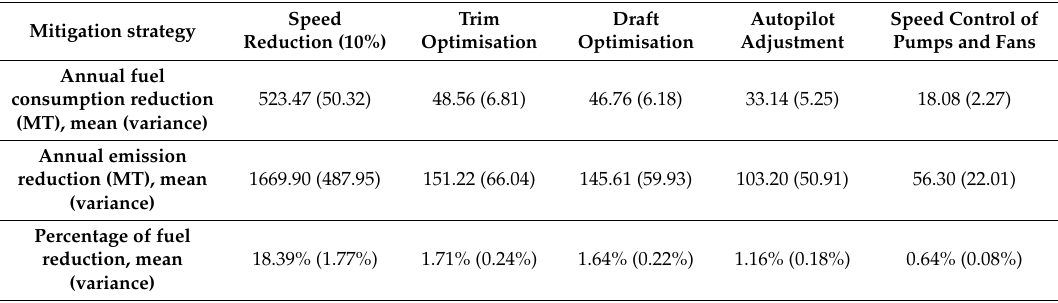
Table 4. Annual fuel consumption reduction, emission reduction and percentage fuel reduction for di ff erent mitigation strategies.